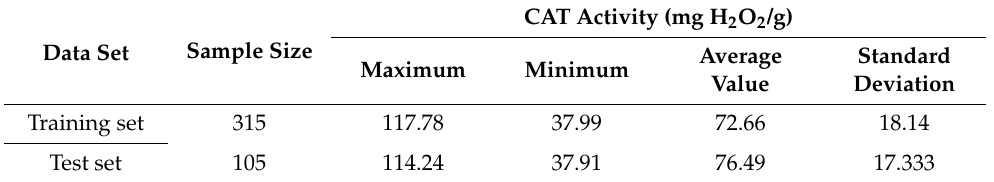
Table 1. Dividing results of